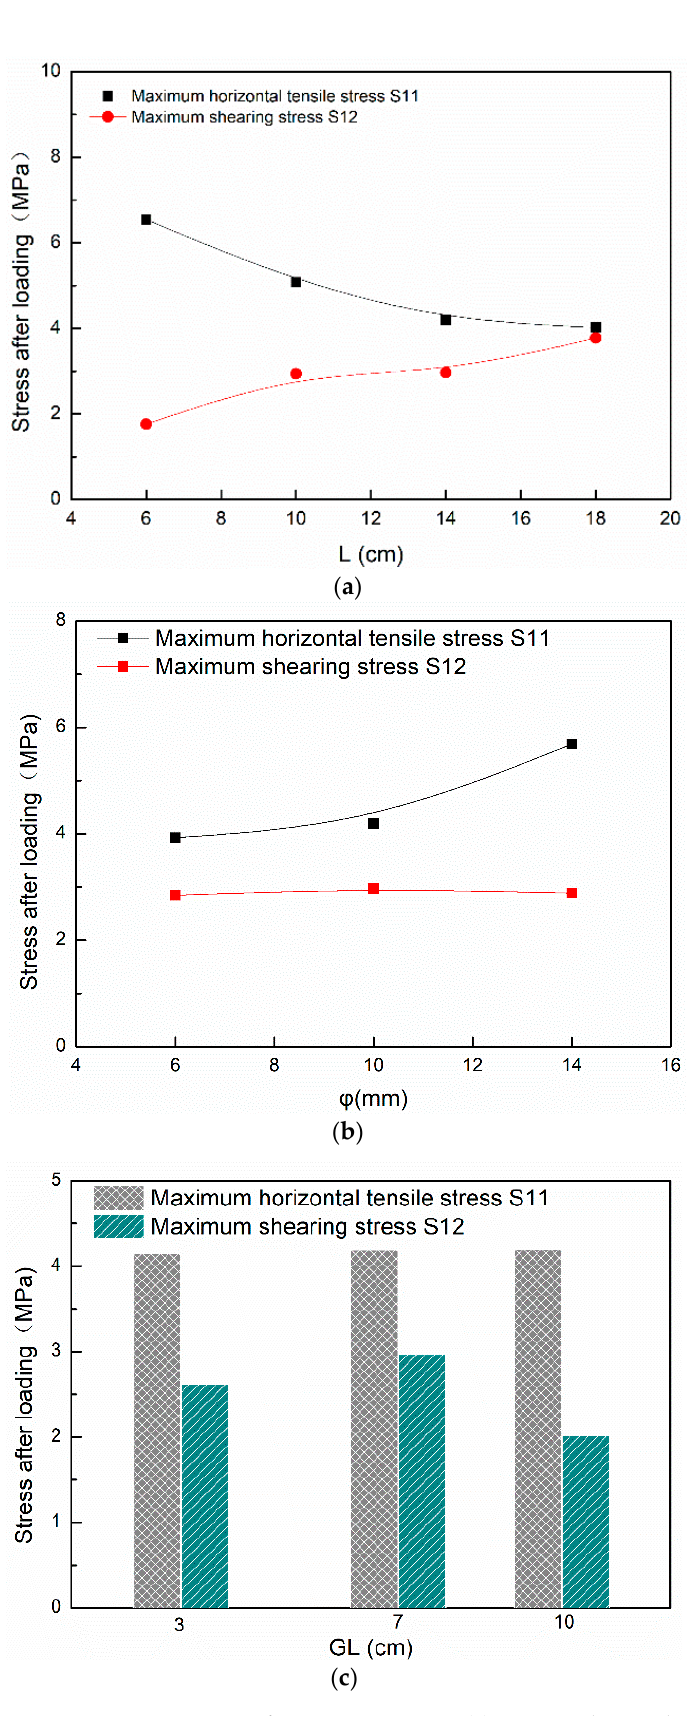
Figure 10. Optimization of I-sensor structure, ( a ) sensing element length optimization, ( b ) sensing element diameter optimization, ( c ) I-beam length optimization.